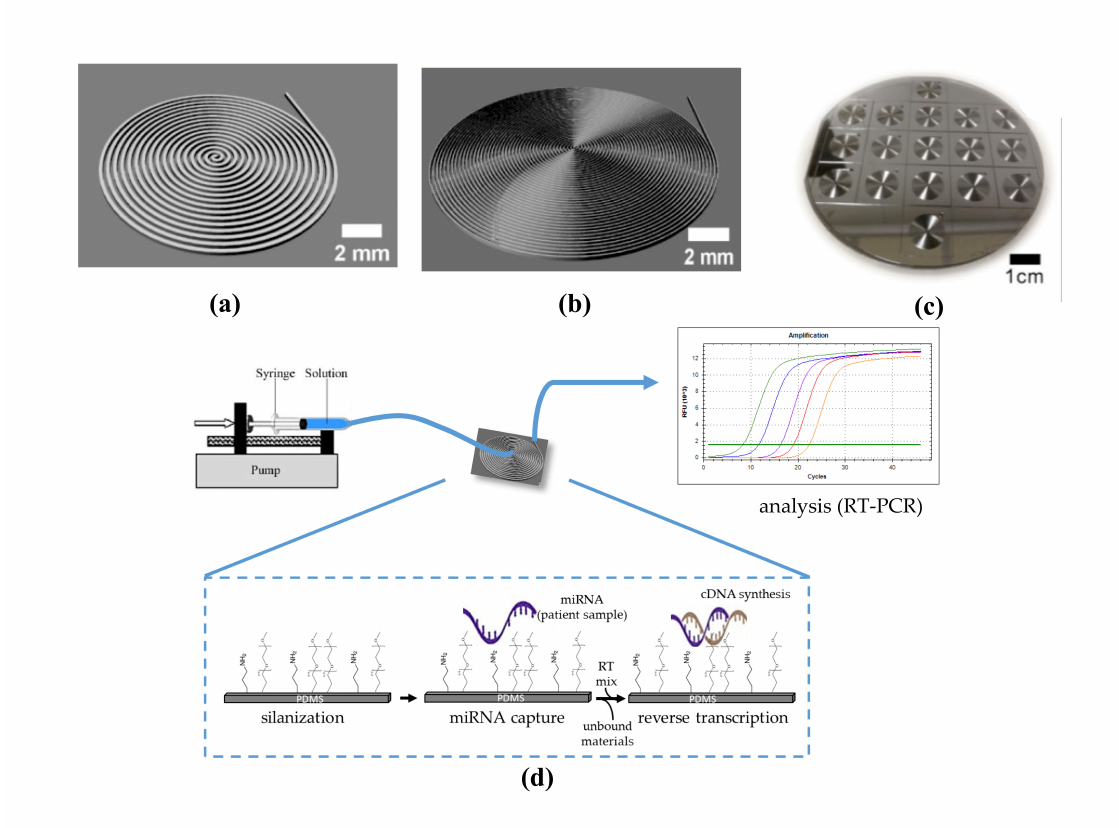
Figure 1. Computer aided design (CAD) representation of the channels featured in the two types of microdevices (Chip A in Panel ( a ) and Chip B in Panel ( b )) used in this study. Panel ( c ): a wafer before dicing in single microdevices. Panel ( d ): experiment workflow. The microdevice is placed in a